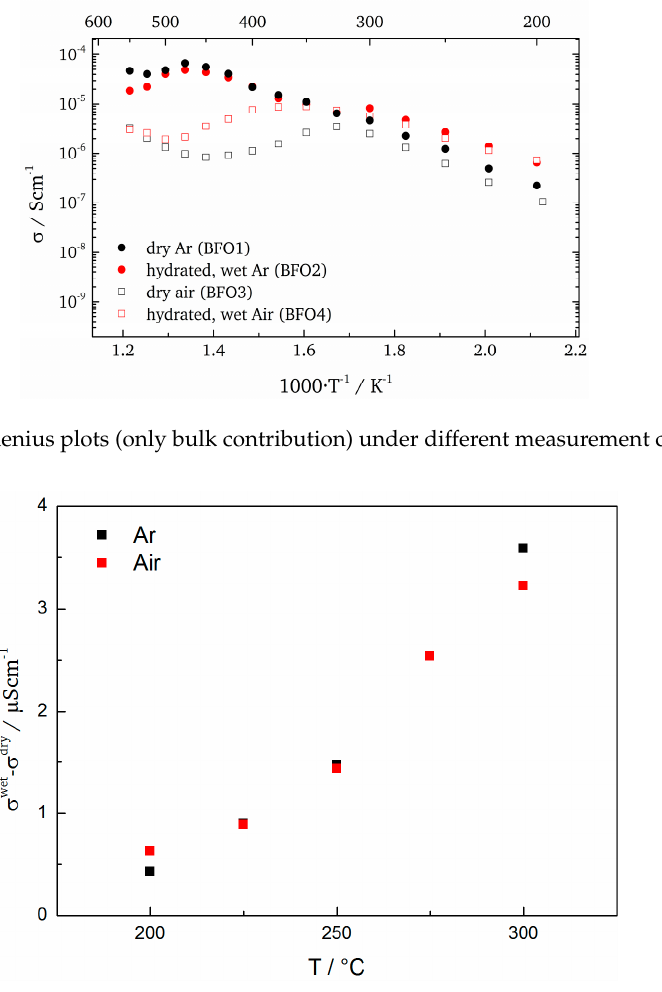
Figure 13. Estimation of the protonic contribution to the total conductivity for measurements in Ar and air.